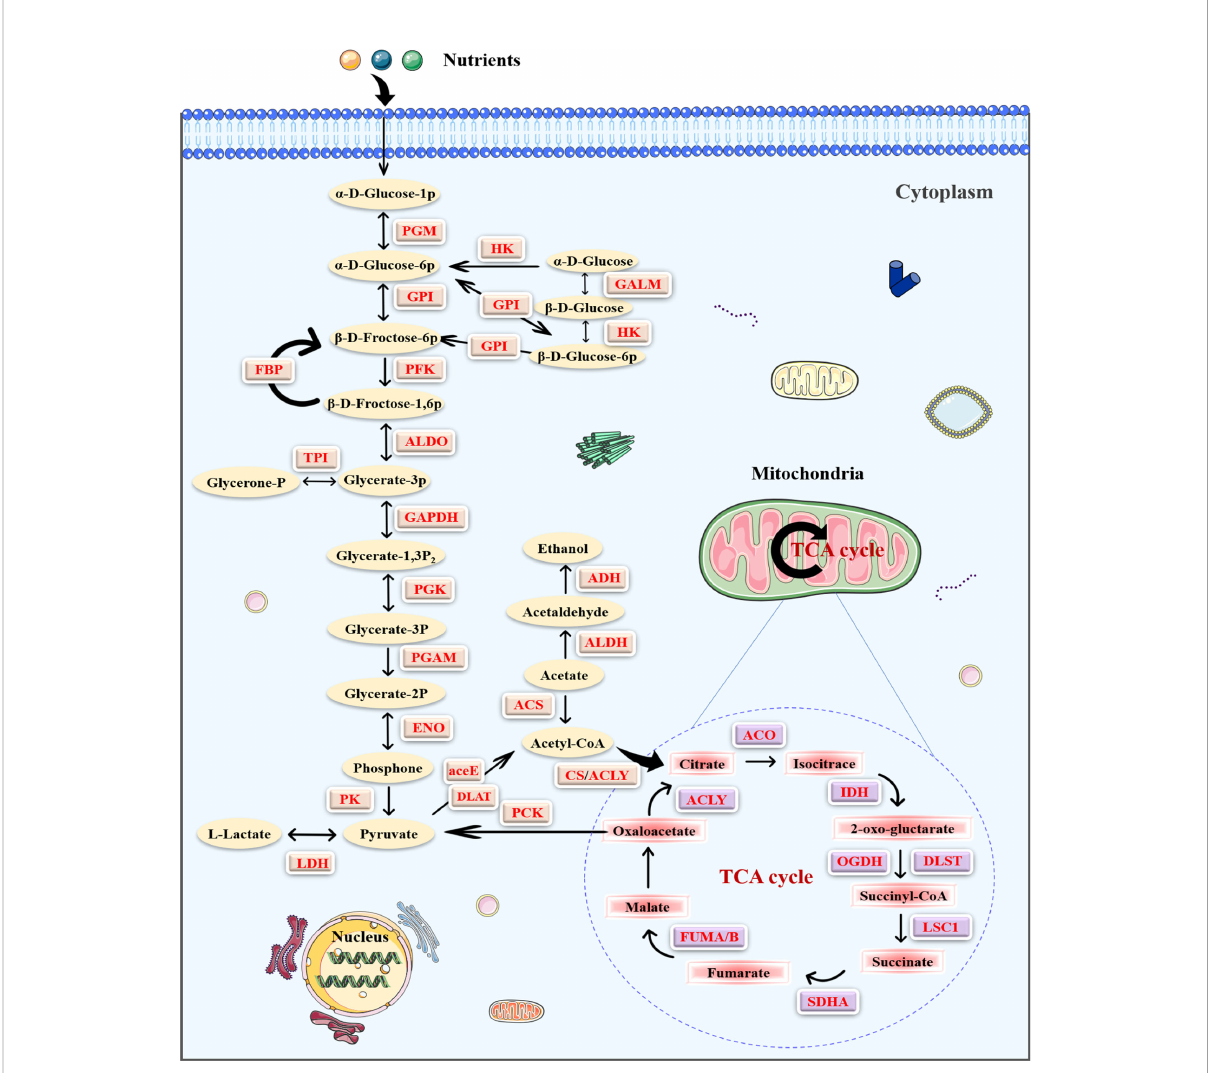
FIGURE 5 The enrichment of the 2-hydroxyisobutyrylation (K hib ) proteins in the central metabolic pathways in pancreatic cancer (PC). The K hib enzymes are marked with